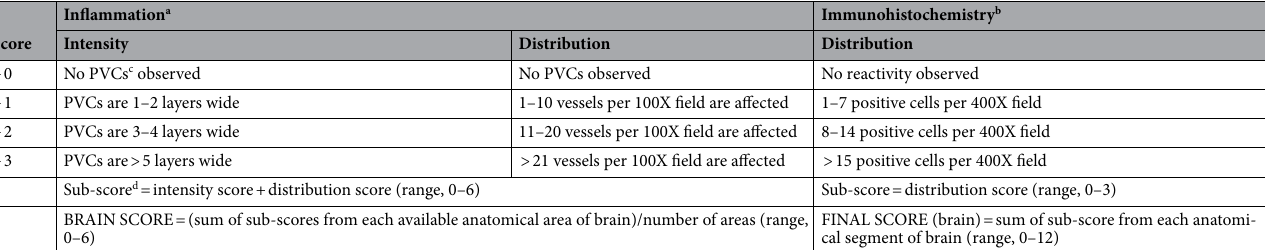
Table 5. Semi-quantitative scoring of inflammation and immunohistochemical reactivity for aquatic bird bornavirus nucleoprotein in the brain and spinal cord of Muscovy ducks experimentally infected with ABBV- 1. a The inflammation score accounts for both intensity and distribution. b The immunohistochemistry score accounts for distribution only. c PVCs = perivascular cuffs. d Sub-scores are defined as scores for each segment of the central nervous system (cerebrum, optic lobe, brainstem, cerebellum, spinal